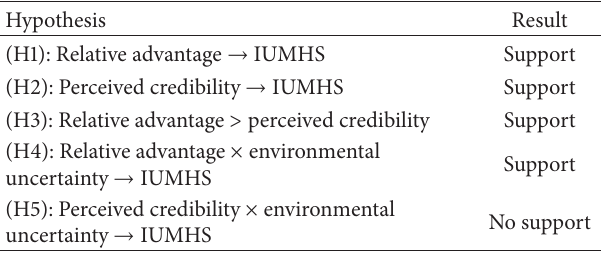
Table 7: Results of hypothesis